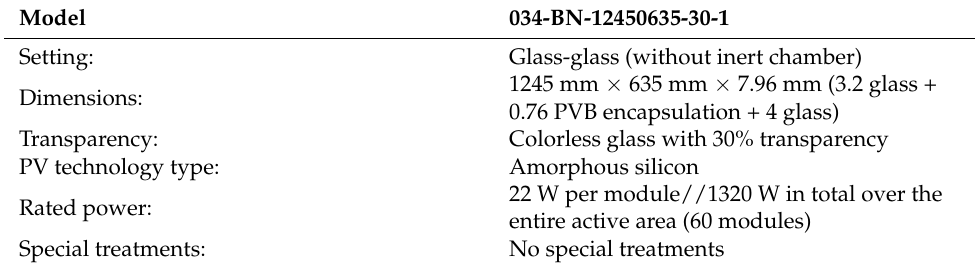
Figure 1. PV greenhouse located on the Duques de Soria University Campus of the UVa. The greenhouse is divided into two equal and contiguous sections, each with an area of 15 m 2 , physically separated by a transparent interior partition wall. The enclosure surface of the sections are made of conventional glass (not PV active) in one section, and PV amorphous silicon (a-Si) glass in the other. The dimensions, mechanical properties (strength and rigidity), and thermal (thermal transmittance) of conventional and PV glasses are similar, so that they do not interfere with the study. This partition has the purpose of being able to compare the horticultural production obtained in both sections in order to evaluate the viability of PV glasses. The PV glass chosen for the design was 034-BN-12450635-30-1, whose main characteristics are described in Table 1. Table 1. Properties of PV glass.